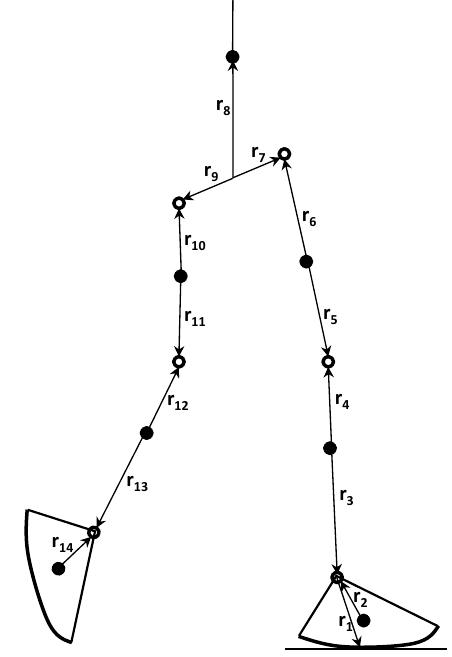
Figure A1. Link segment model showing the position vectors in each